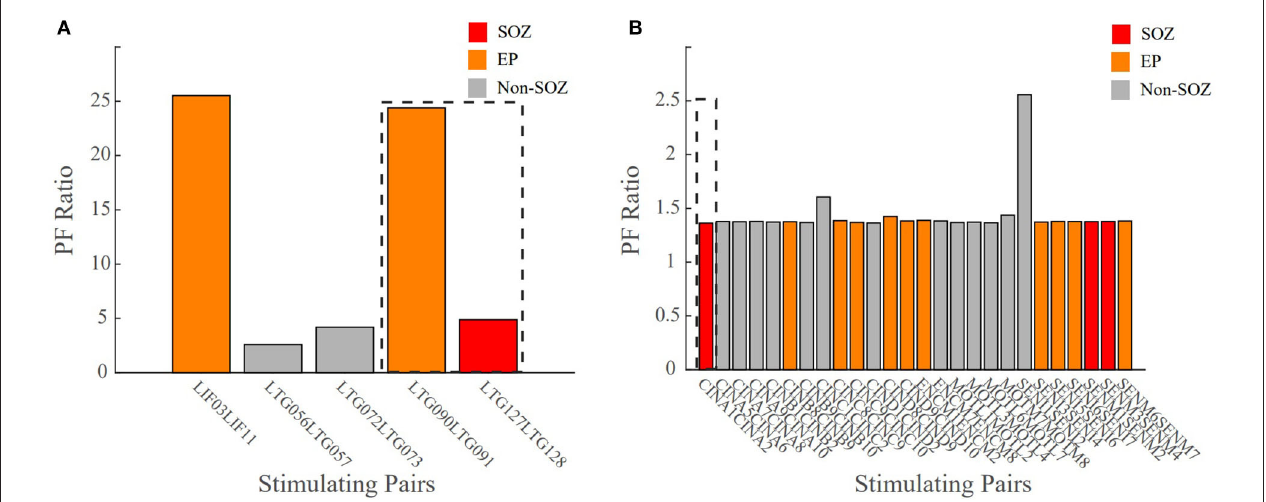
FIGURE 9 | Bar plot of the PF ratio transfer functions for two patient datasets with surgical outcome data. Dashed lines indicate the areas of resection. (A) CCLow Patient 3 who now is seizure free (ESII), (B) CCHigh Patient 7 who still has seizures (ES IV). Red indicates electrode pairs in the clinically annotated seizure onset zone (SOZ), orange is early spread (EP), and gray are all others. In surgical success, the resected regions closely matched the clinically annotated SOZ regions with high PF ratio